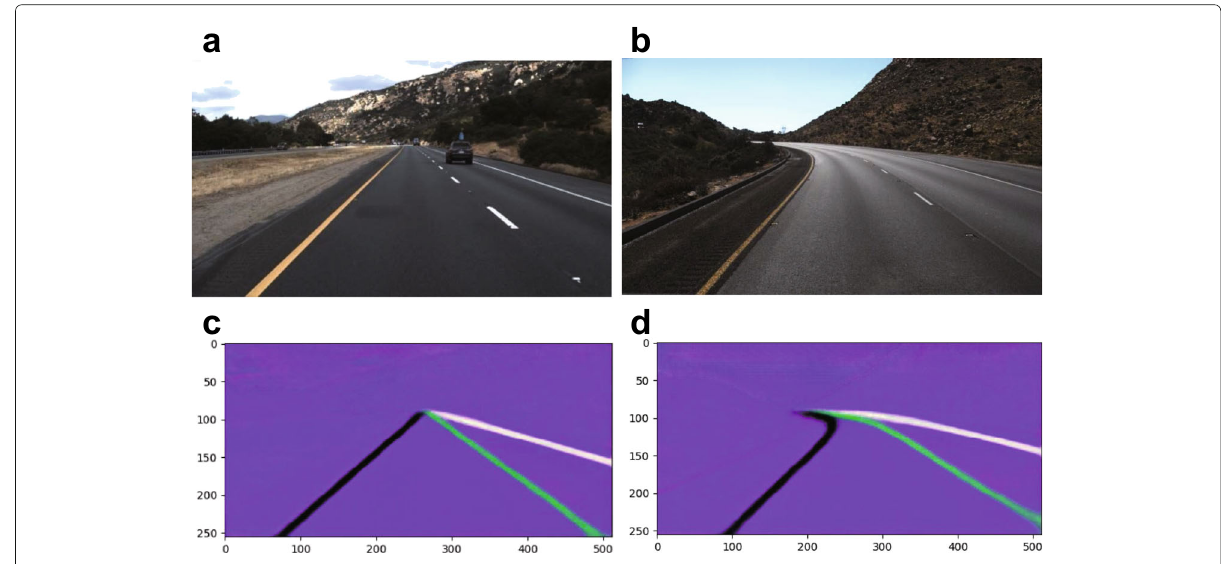
Fig. 2 Lane instance embedding segmentation